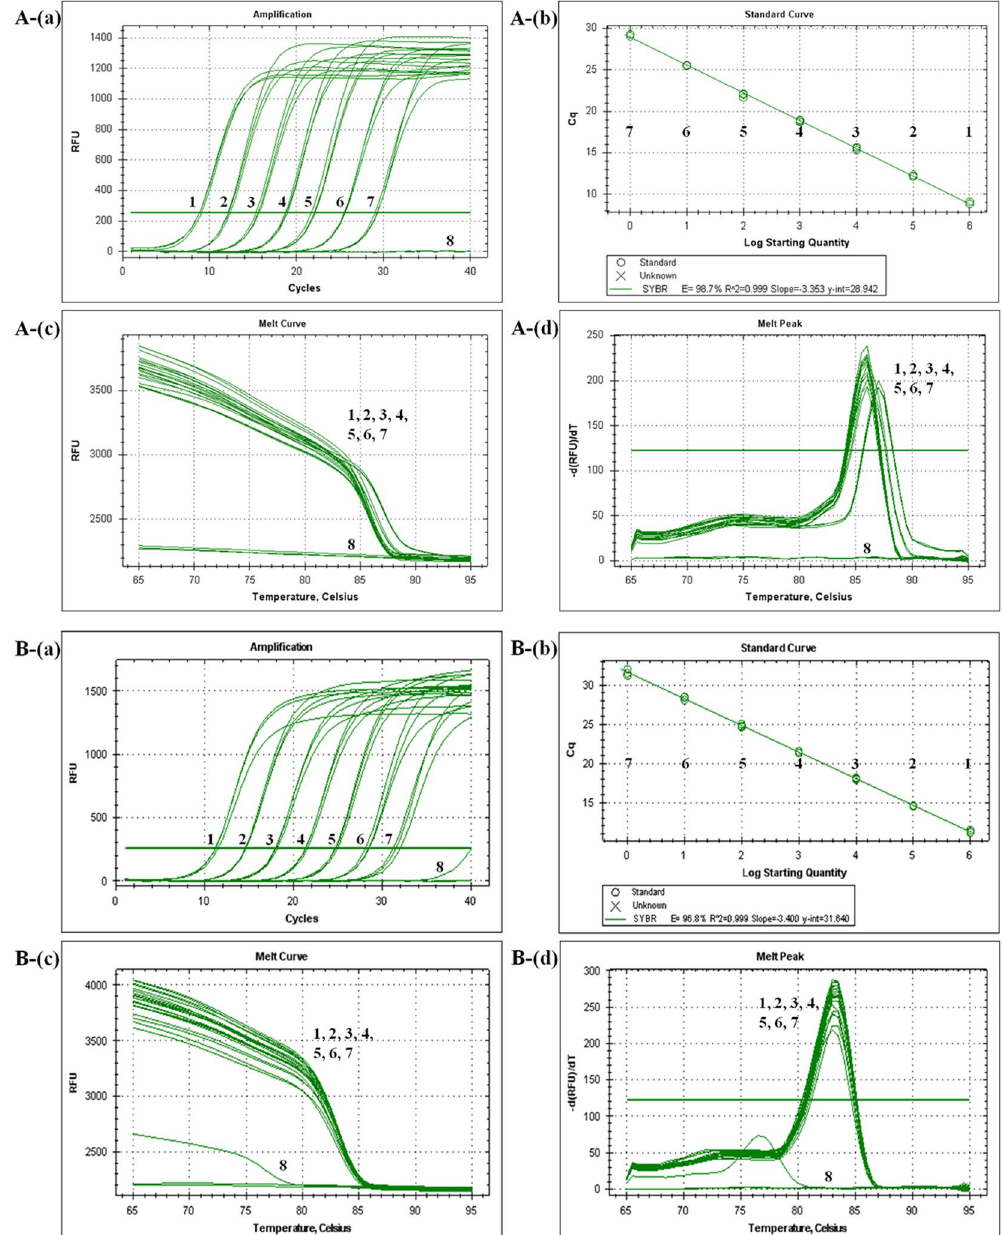
Figure 2. Specificity, melting peak and standard curve analysis of the SYBR Green qPCR assay with the Bam249F/R and BS310F/R primer sets. ( A ) B. velezensis . (a) Fluorescence intensity as a function of template concentration. For each assay, a series of 10-fold dilutions of cloned DNA (ranging from 1.42 × 10 3 to 1.42 × 10 9 copies/ µ l) was used as the template (1–7, sample dilutions). (b) Standard curve derived from the amplification plot. (c) Melting curve analysis (1–7, sample dilutions). (d) Melting peak analysis (1–7, sample dilutions). The amplified product derivatives of the relative fluorescence units [ − d(RFU)/dT] were plotted as a function of temperature (amplified product, 86.0 °C). The large peak indicates the amplified product, while the small peak indicates the no-template control. ( B ) B. subtilis subsp. subtilis . ( a ) Fluorescence intensity as a function of template concentration. For each assay, a series of 10-fold dilutions of cloned DNA (ranging from 1.39 × 10 3 to 1.39 × 10 9 copies/ µ l) was used as the template (1–7, sample dilutions). (b) Standard curve derived from the amplification plot. (c) Melting curve analysis (1–7, sample dilutions). (d) Melting peak analysis (1–7, sample dilutions). The amplified product derivatives of the relative fluorescence units [ − d(RFU)/dT] were plotted as a function of temperature (amplified product, 83.5 °C). The large peak indicates the amplified product, while the small peak indicates the no-template